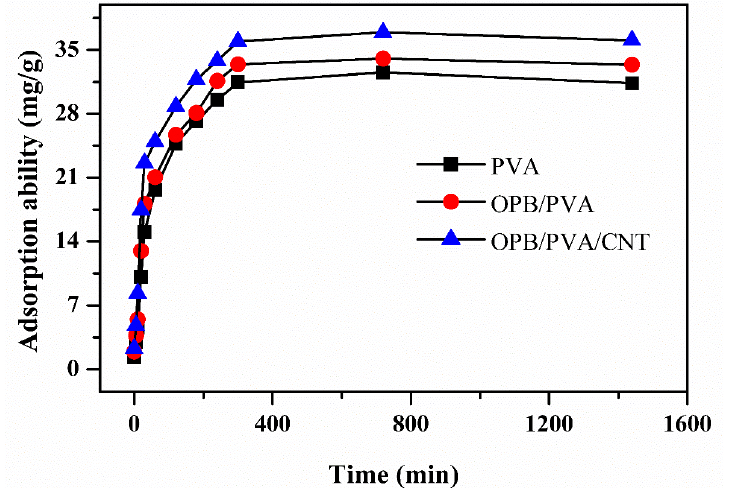
Figure 9. Effect of contact time for the adsorption of Pb(II) onto the PVA, OPB/PVA and OPB/PVA/MWCNTs hydrogel adsorbents. Experimental conditions: adsorbent dose = 0.5 g, Pb(II) concentration = 65 mg/L and pH = 7 at room temperature.